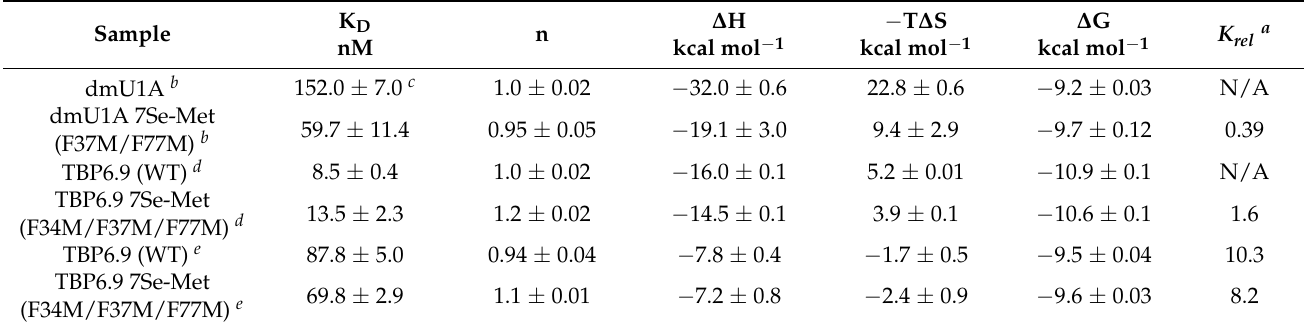
a The ratio of K D values of the mutant divided by the matched wildtype (i.e., dmU1A or TBP6.9). 24-mer in Figure 1a. c Errors represent standard errors of the mean for multiple measurements. d The RNA sample in the cell was the TAR RNA 27-mer in Figure 1b. e The RNA sample in the cell was the GNRA-TAR RNA 30-mer depicted in Figure